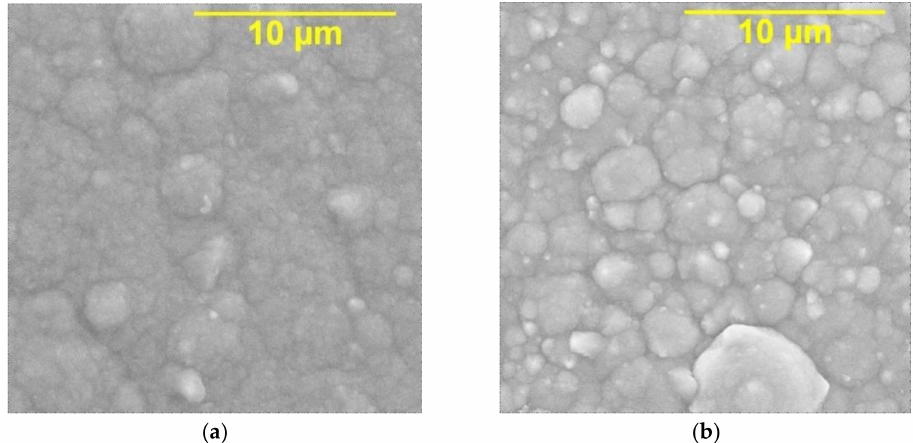
Figure 4. SEM images of nickel surface ( a ) and nickel–GO CEC ( b ). The time ratio of the cathodic and anodic periods t c t a = 10:1. Magnification ×